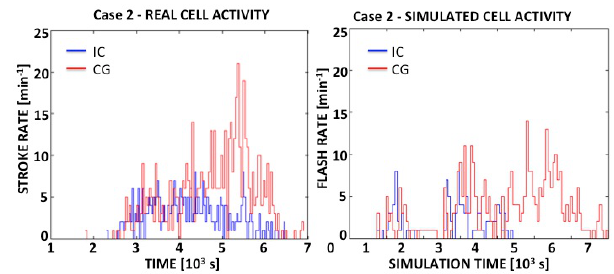
Fig. 11. Same as Fig. 10, but for Case 2 (Rome, 2 July